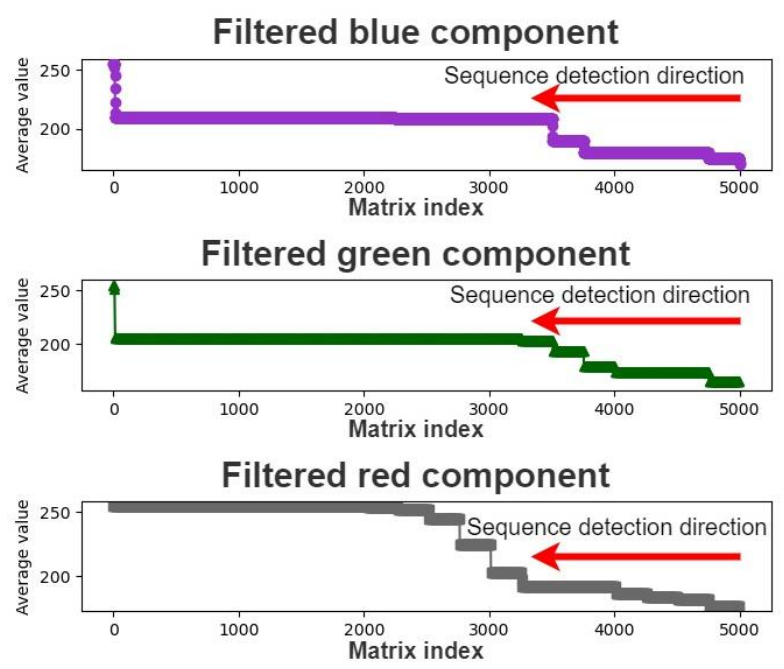
Figure 18. Sequence detection direction of the developed component threshold decision module.